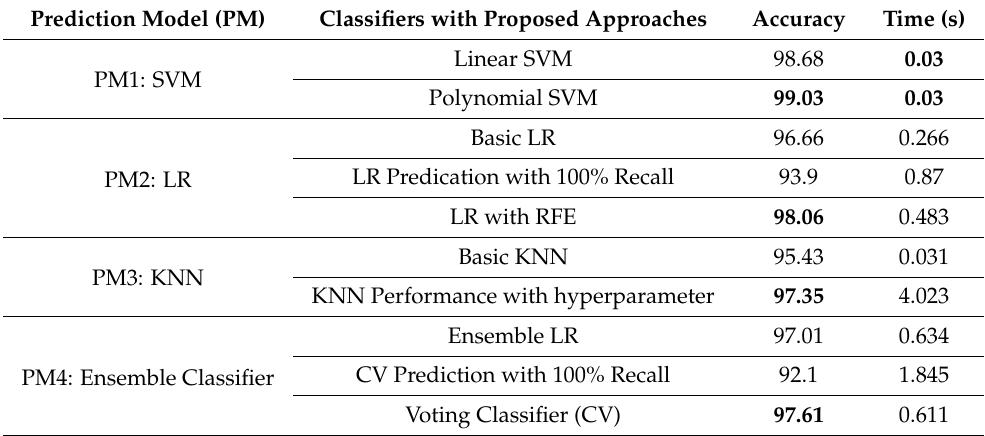
Table 6. Execution time comparison of each model along with best-achieved